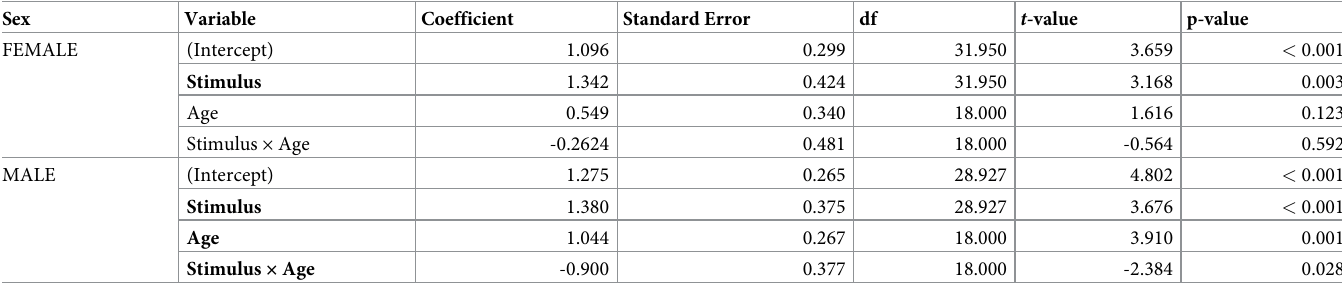
Table 2. Result of the estimation of a model (LMM) fitted to phonotaxis